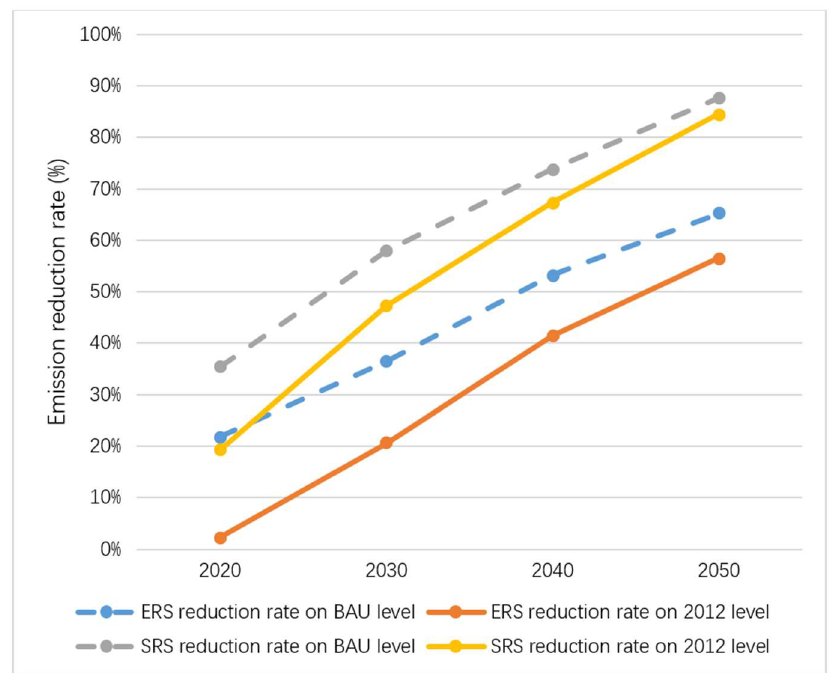
Figure 8. Emission reduction rates of different lime products in two emission reduction scenarios.